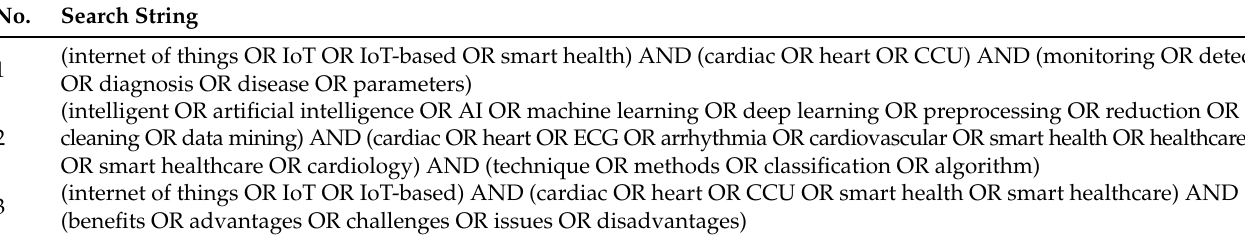
Table 3. Search strings used for data